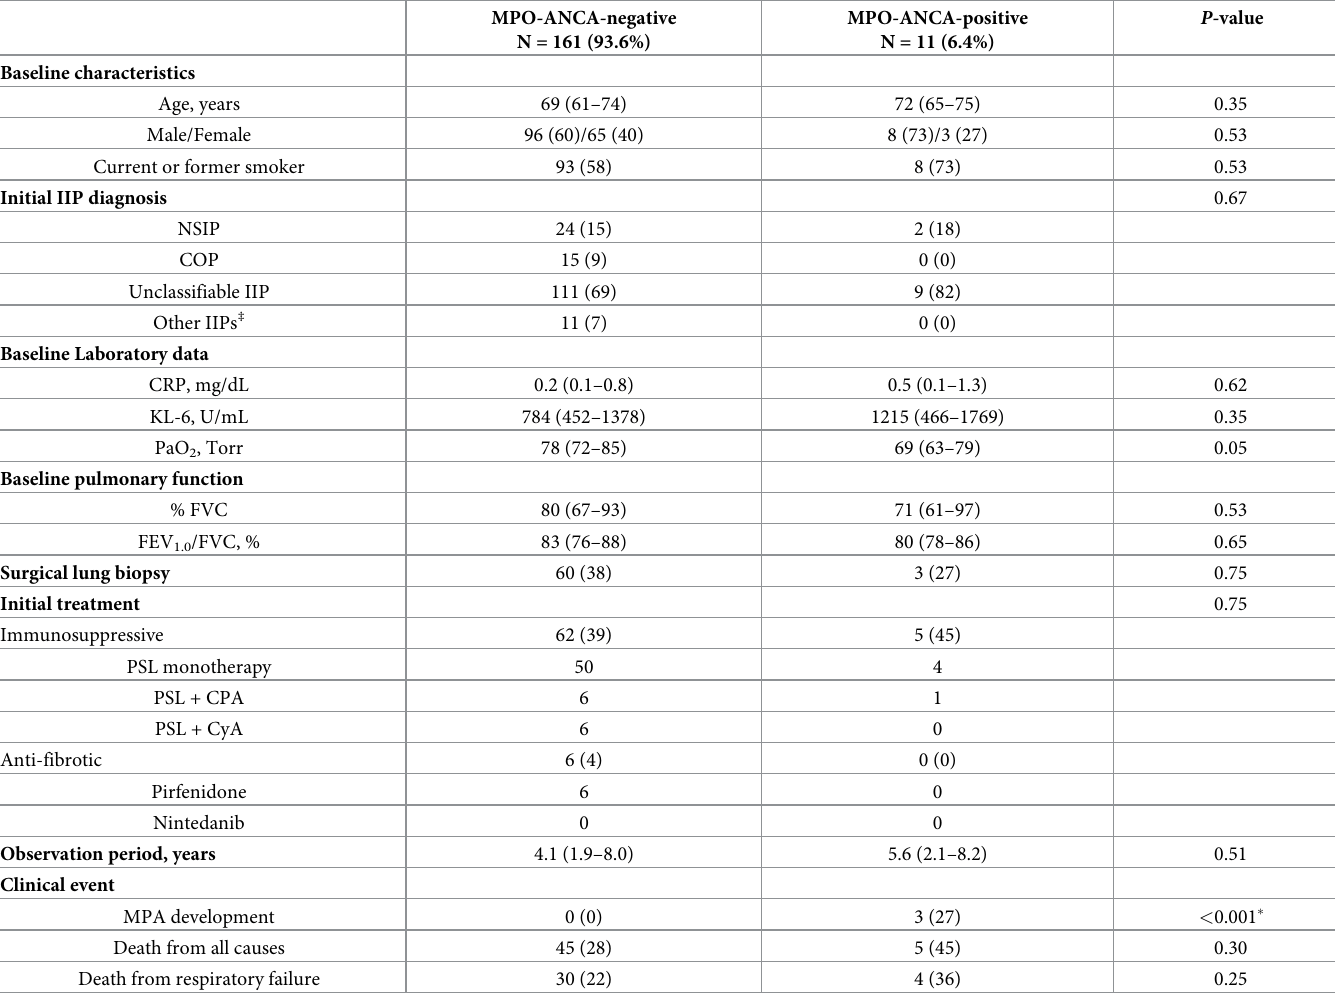
Table 2. Comparison of patients who were initially diagnosed as having non-IPF on the basis of MPO-ANCA results.